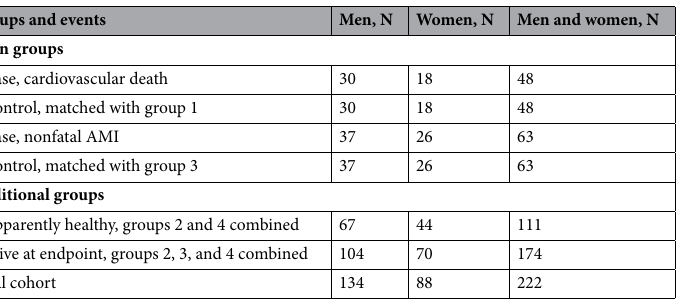
Table 1. Number of participants in the case and control groups used for model assessment. AMI, acute myocardial